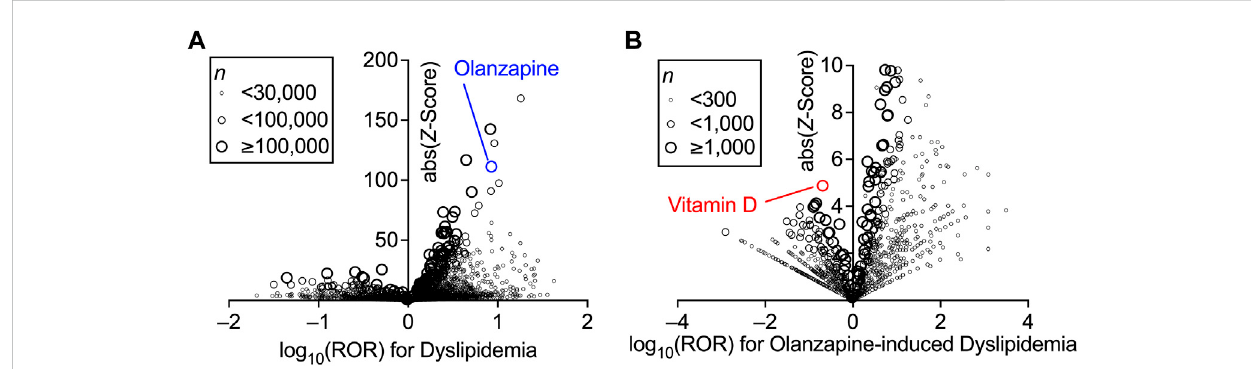
FIGURE 1 Increased incidence of dyslipidemia with the prescription of drugs and confounding effects of concomitant drugs on the olanzapine-induced dyslipidemia in FDA Adverse Event Reporting System (FAERS) data. Volcano plots for visualizing the reporting odds ratio (ROR, on a log scale) and its statistical signi fi cance (absolute Z -score) are shown. Each circle indicates an individual drug, and the size of the circle re fl ects the number of patients taking the drug. (A) Strong and signi fi cant increases in the ROR for dyslipidemia were seen in patients using olanzapine. (B) Within the population taking olanzapine, confounding effects of concomitantly used drugs on the incidence of olanzapine-induced dyslipidemia were calculated thoroughly and plotted. Overall values are presented in (Supplementary Tables S2,